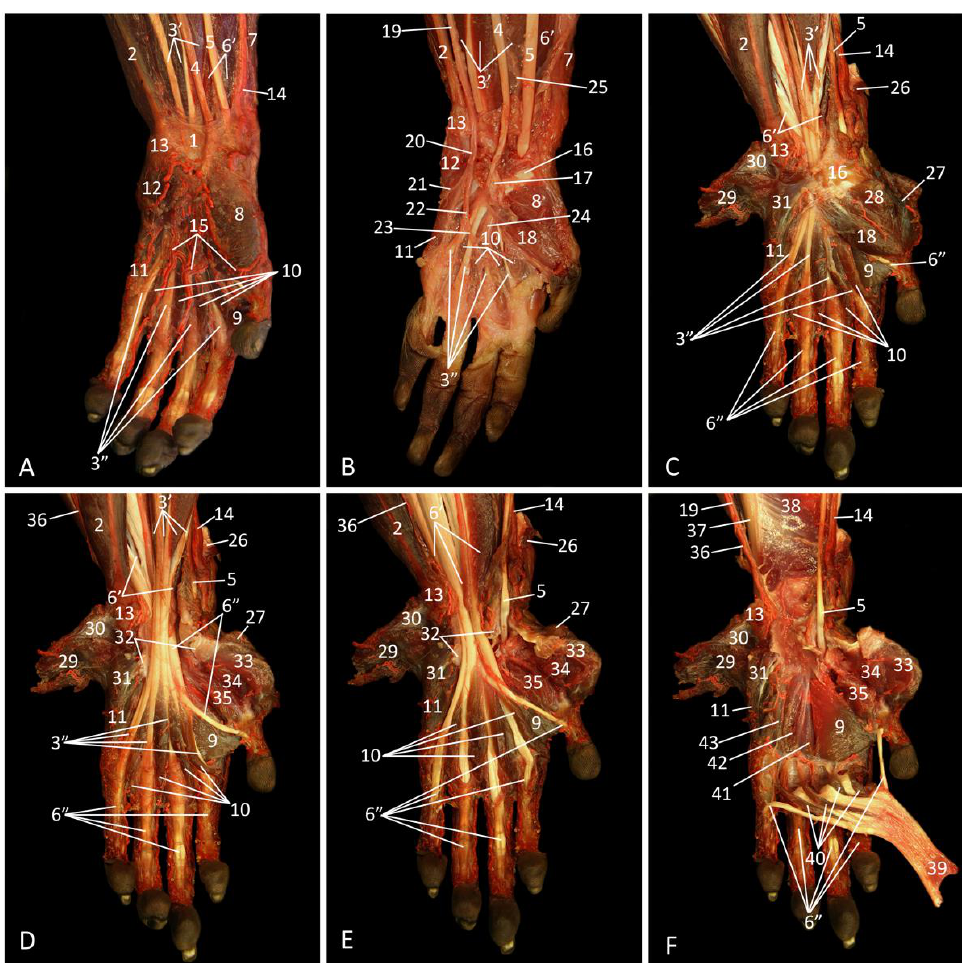
Figure 11. Palmar view of the left hand; the arterial system is filled with red latex, except for image B. ( A ): Superficial layer; ( B ): Second layer, after the arcus palmaris superficialis and the ligamentum carpi palmare have been removed; ( C ): Third layer, after the m. abductor digiti primi brevis, the m. abductor digiti quinti, and the m. palmaris brevis have been retracted, and after the removal of the m. palmaris longus and the superficial palmar nerves; ( D ): Fourth layer, after the m. opponens digiti primi and the m. flexor digiti primi brevis superficialis have been retracted, and after the transection of the retinaculum flexorum; ( E ): Fifth layer, after the resection of the m. flexor digitorum superficialis; ( F ): Deepest layer, after transecting and retracting the tendons of the m. flexor digitorum profundus and after the amputation of the m. flexor carpi ulnaris.